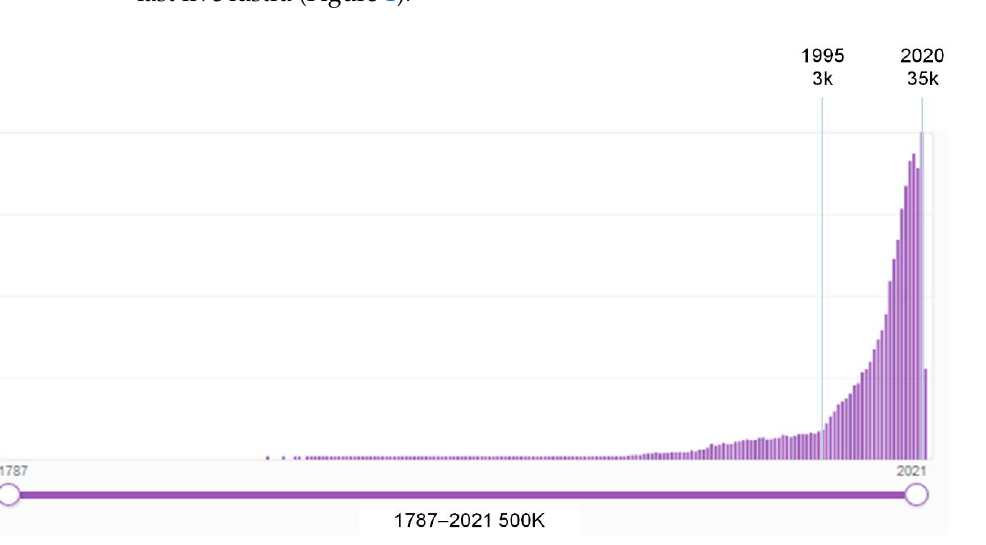
Figure 1. Number of answers per year from SciFinder n to the query ‘antibacterials’ [5].